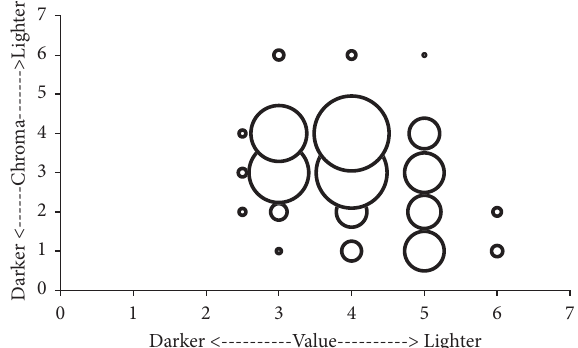
Figure 4: Soil color value and chroma indices of samples collected from Damot Gale, Damot Sore, and Sodo Zuria districts in Ethiopia. The size of each bubble is proportional to the number of samples at the corresponding value/chroma